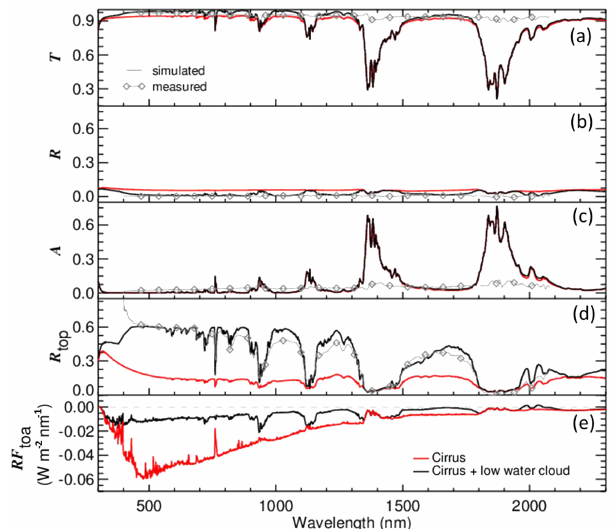
Figure 12. Same as Fig. 10 assuming the mixture according to Baum et al. (2005) between 6.7 and 8.5km altitude ( τ Cirrus = 1). An additional low water cloud with τ = 20 is included between 1.0 and 1.25km altitude. Inserted is the measurement case (gray dia-